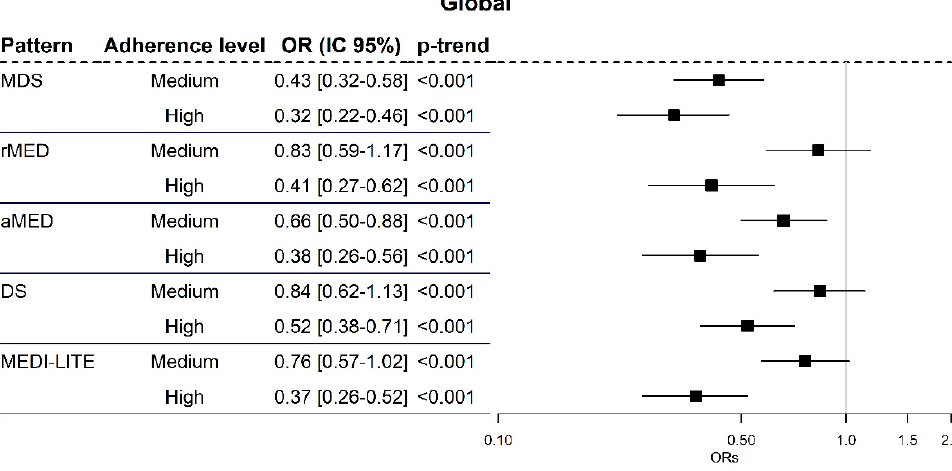
Figure 1. Odds ratios of risk of gastric cancer according to adherence level to various rates compared with low adhesion.